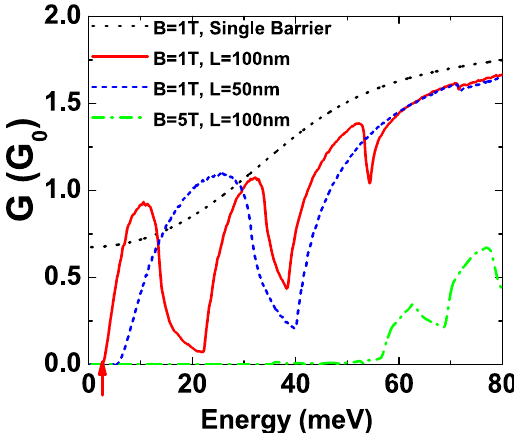
Figure 4. Transport conduction as a function of Fermi energy with different magnetic fields and superlattice period lengths. The red arrow indicates the conductance gap as a manifestation of a finite